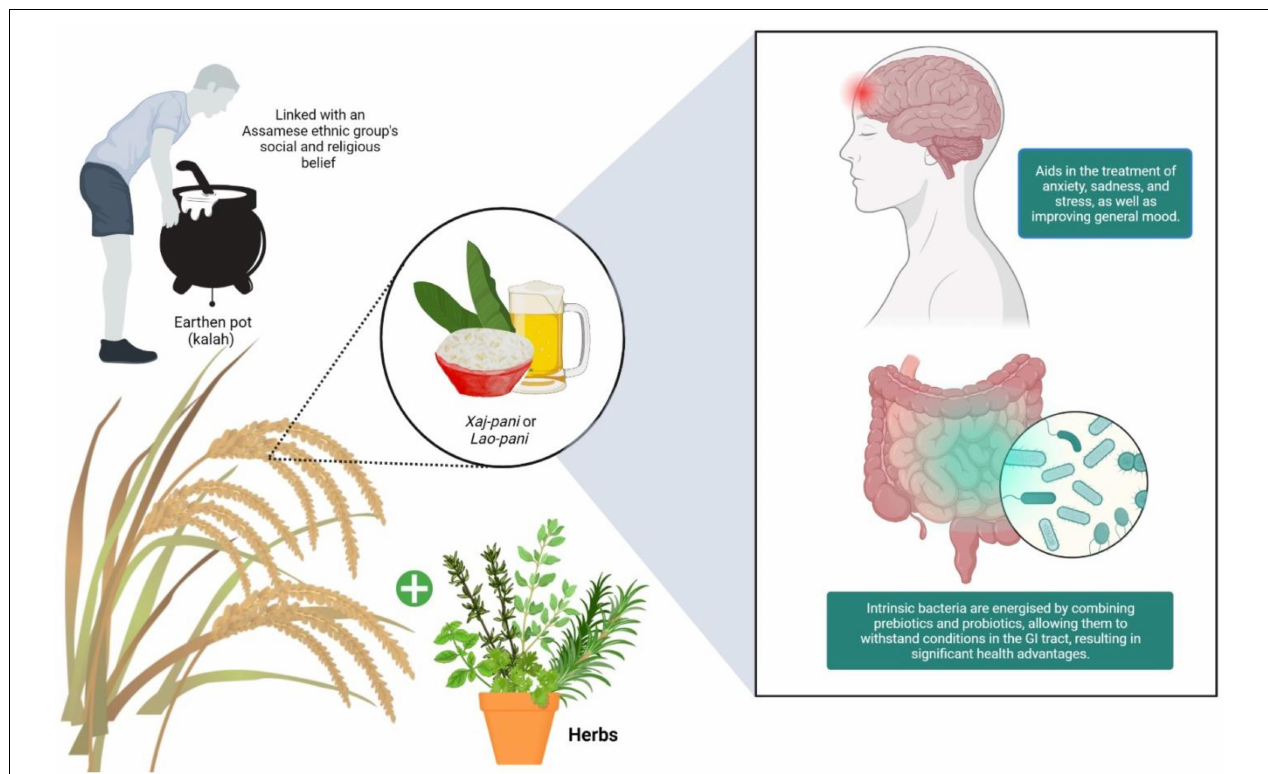
FIGURE 1 | Synbiotics are well-known for their therapeutic effects, which include assisting in the management of mental health issues like anxiety, depression, and stress by elevating general